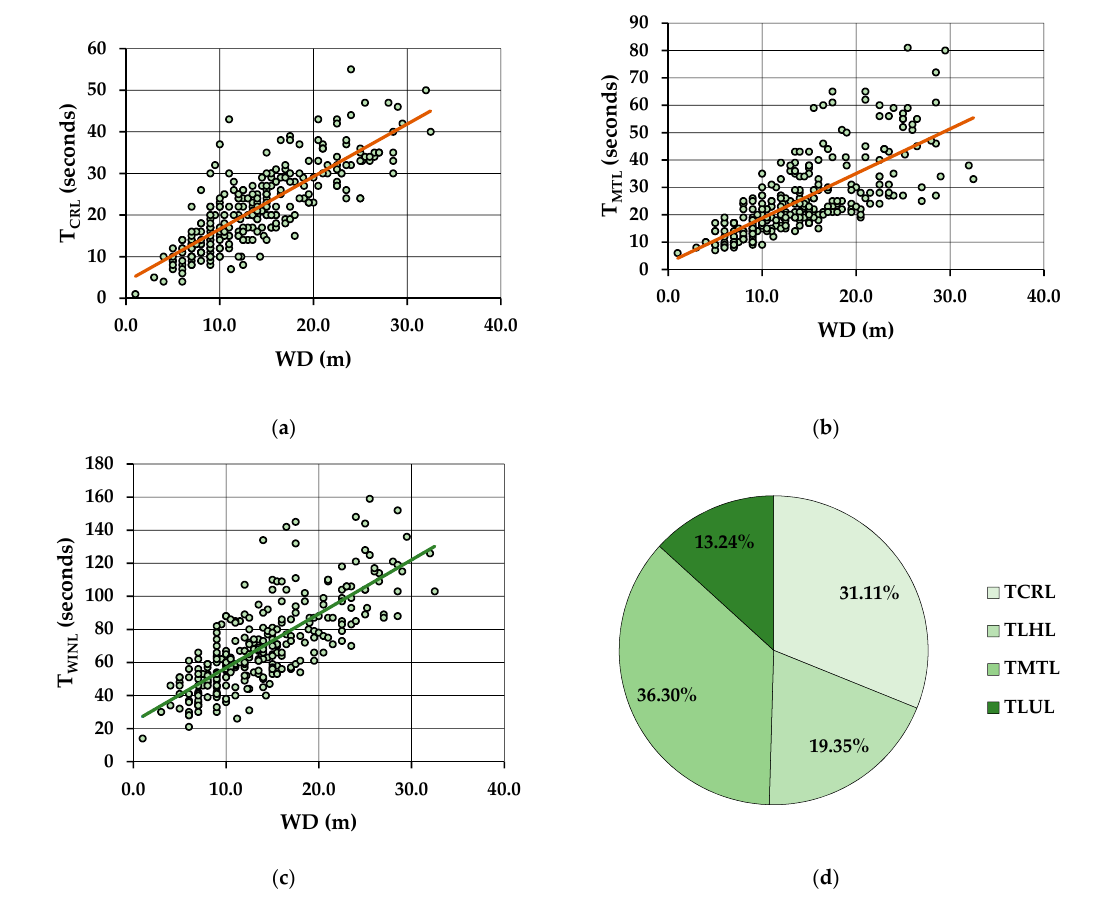
Figure 3. Time consumption estimates: ( a ) variation in log-based cable releasing time (T CRL ) as a function of winching distance (WD); ( b ) variation in log-based mechanical winching time (T MTL ) as a function of WD; ( c ) variation in log-based winching time (T WINL ) as a function of WD; ( d ) share of elemental time consumption in log-based winching. The variability in time consumption data increased proportionally with the winching distance, suggesting the contribution of other unaccounted factors to the time consump- tion. Since, by the results of the correlation analysis, the log length (LL) variable was ex- cluded due to a high correlation with log volume (LV), attempts were made to model by stepwise regression the time consumption for mechanical traction (T MTL ) and for the log- based winching work cycles (T WINL ) as a function of logs’ volume (LV) and winching dis- tance (WD), respectively. For cable releasing (T CRL ), only the winching distance was con- sidered as a predictor. Table 5 includes the final simple linear models of the three time consumption categories along with their main statistics. As shown, log volume (LV) was not significant in explaining the variation in mechanical traction (T MTL ) and log-based winching work cycle (T WINL ) time ( p = 0.24, data not included), respectively.